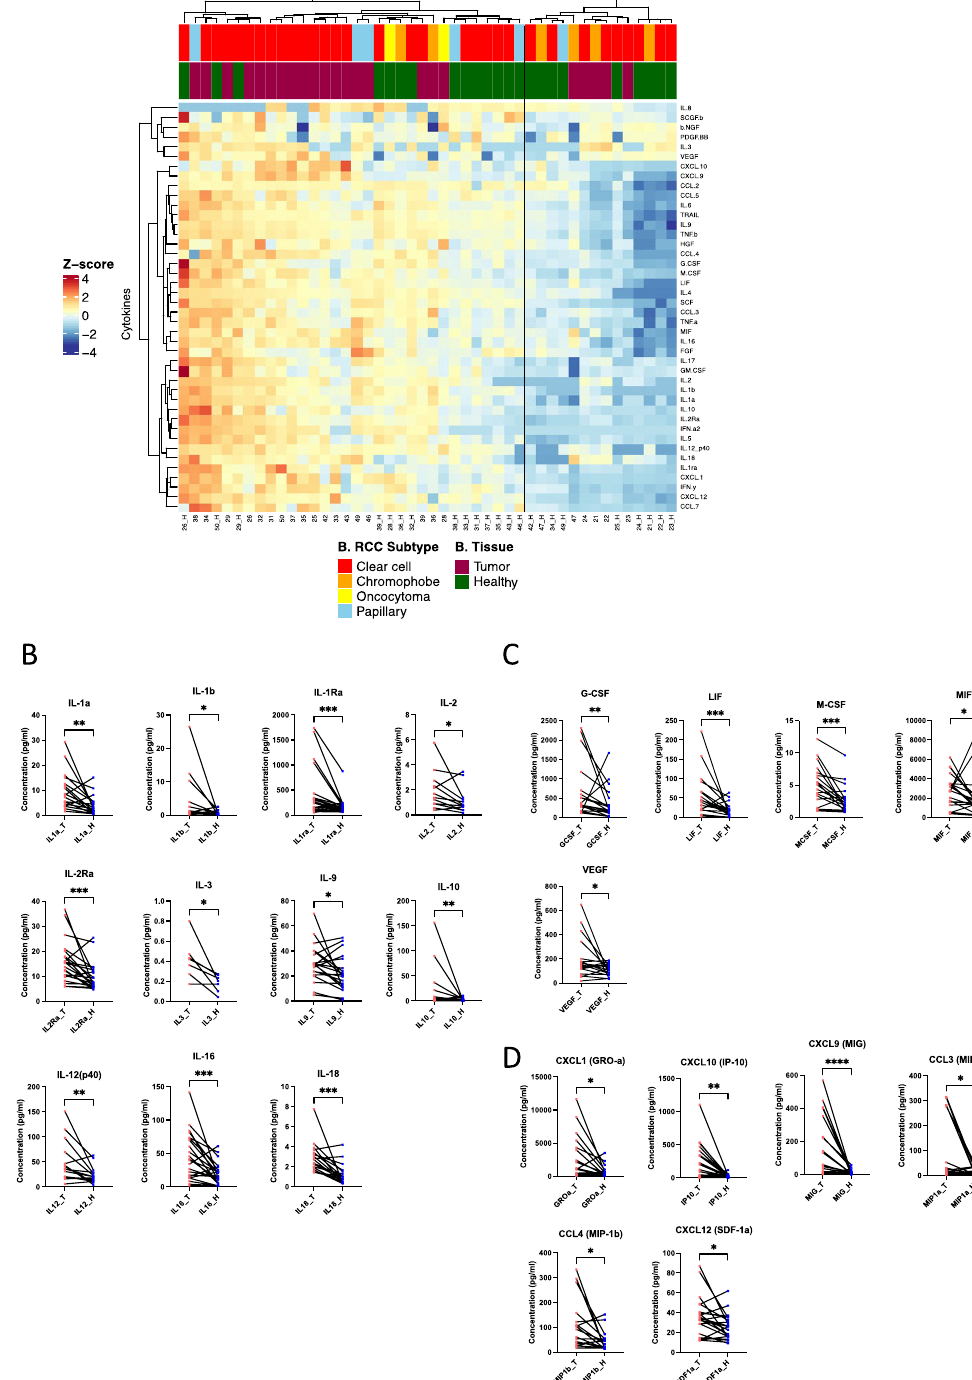
Figure 1. ( A ) Heatmap showing the cytokine profile of 23 matching RCC tumors and healthy adjacent tissue samples using unsupervised clustering. Upper color keys represent clinical parameters (RCC histology and type of tissue sample). Euclidean distance clustering and ward.D2 linkage methods were used from log 2 transformed data values. Numerical identifiers at the bottom of the heatmap refer to individual patient tumors, where “_H” codes correspond to the healthy tissue counterparts. From the cytokine profiles, patients may be divided into two large clusters – those with high and those with low cytokine expression profiles. Results including all tumor samples and only ccRCC cases are found in Supplementary Fig. S1A,B. ( B – D ) Comparison of each cytokine profile between the matching tumor and healthy adjacent renal tissue samples show significant differences, with the tumors generally displaying a higher expression and broader range of cytokines. The cytokines were grouped based on their biological qualities: ( B ) interleukin families, ( C ) growth, inhibiting and stimulating factors, and ( D ) chemokines. All other cytokines are found in Supplemental Fig. S2A–E. Wilcoxon matched-pairs signed rank statistical testing with a 95% confidence level was used. * p < 0.05; ** p < 0.01; *** p < 0.001; **** p <